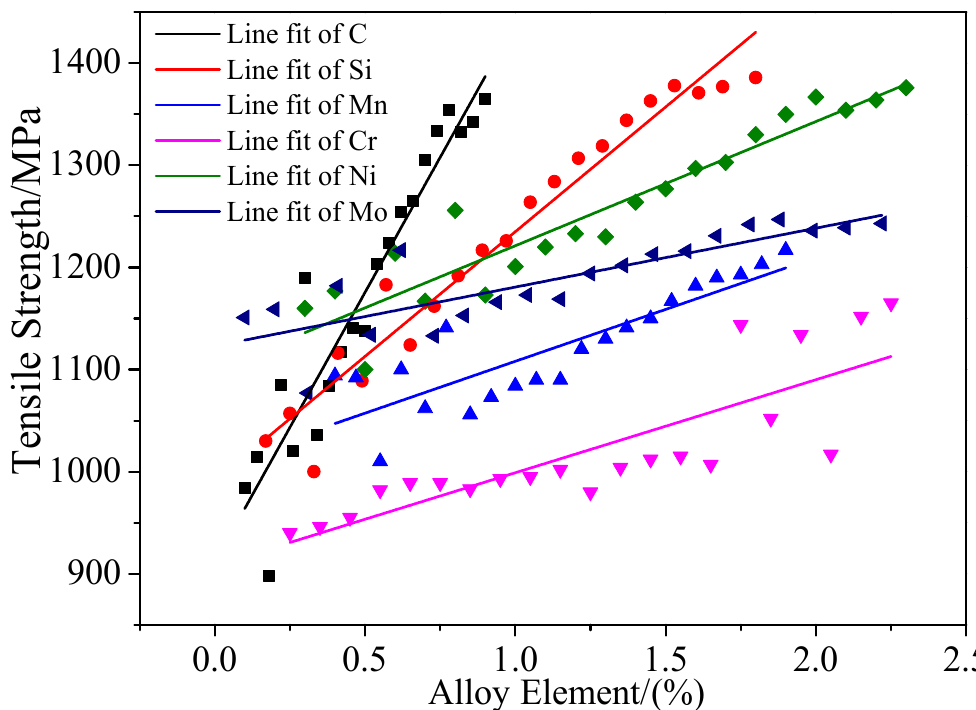
Figure 9. Influence of model input variables on the tensile strength.